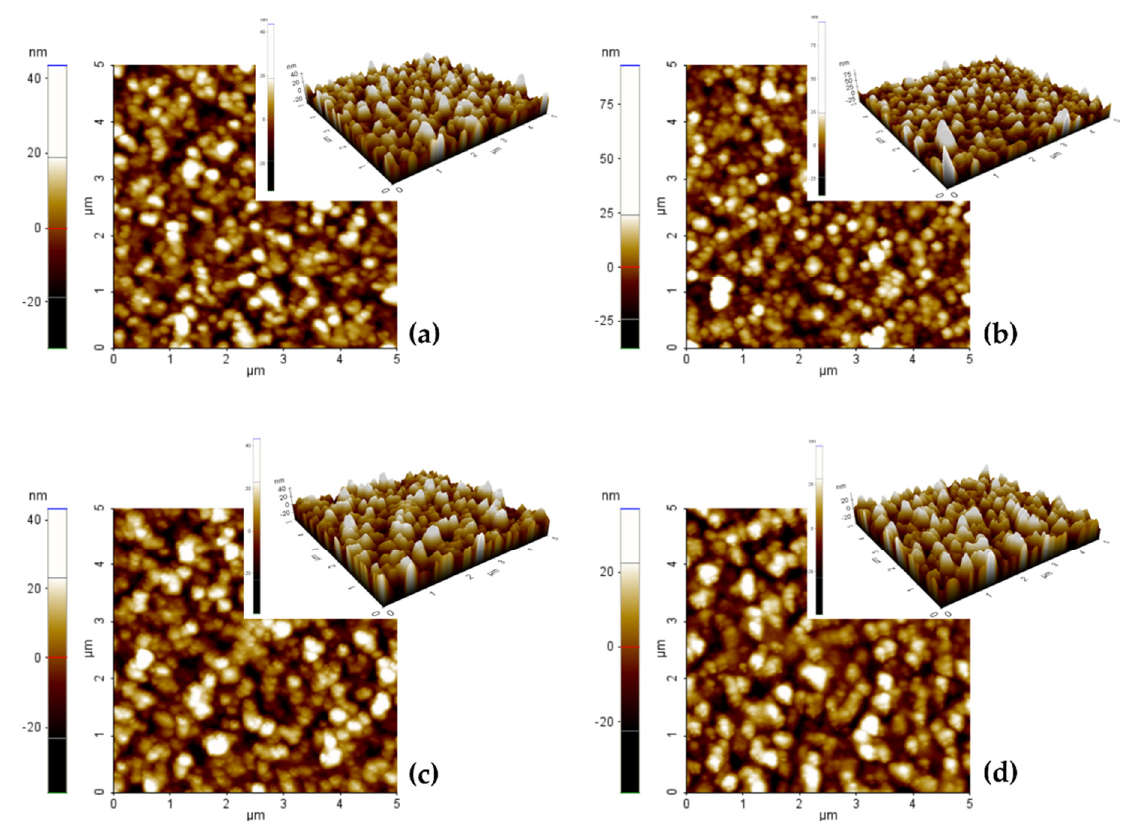
Figure 3. AFM images of electrodeposited CoPt alloy for various electrodeposition solution: ( a ) pH = 2.5 solutions without saccharin addition, ( b ) pH = 2.5 solutions with saccharin addition, ( c ) pH = 5.5 solutions without saccharin addition and ( d ) pH = 5.5 solutions with saccharin